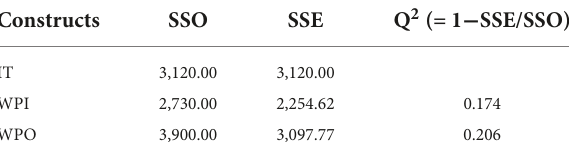
TABLE 6 Predictive relevance ( Q 2